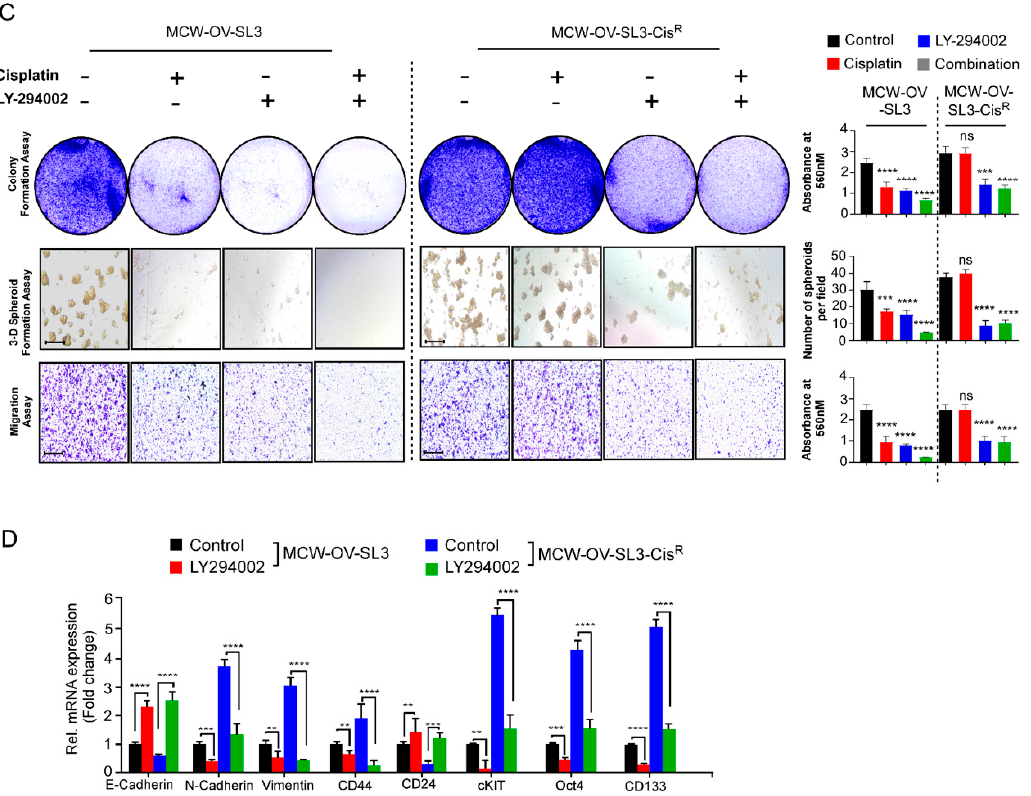
Figure 5. PI3K inhibitor treatment reduced EMT, cancer stemness, and chemoresistance in the MCW ‐ OV ‐ SL3 cell line. ( A ) MCW ‐ OV ‐ SL3 and MCW ‐ OV ‐ SL3 ‐ CisR cells were treated for 24 h with LY ‐ 294002. Cell lysates were prepared and immunoblotted using the antibodies indicated (see Figure S3). ( B ) MCW ‐ OV ‐ SL3 and MCW ‐ OV ‐ SL3 ‐ CisR cells were treated with either cisplatin (2.2 and 6.2 μ M), LY ‐ 294002 (5 and 10 μ M), or their combination (cisplatin 1.1 and 3.1 μ M), LY ‐ 294002 (2.5 and 5 µ